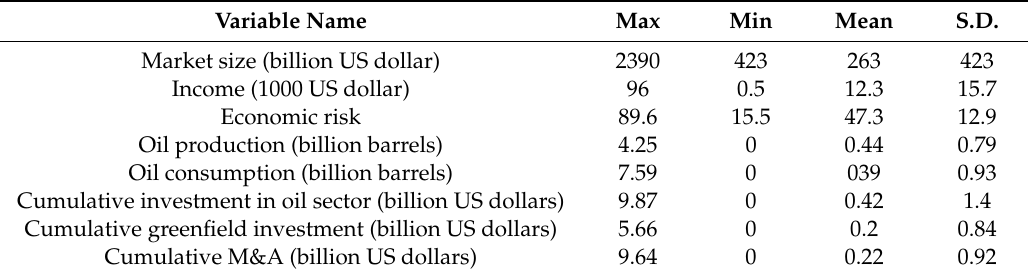
Table 1. Summary